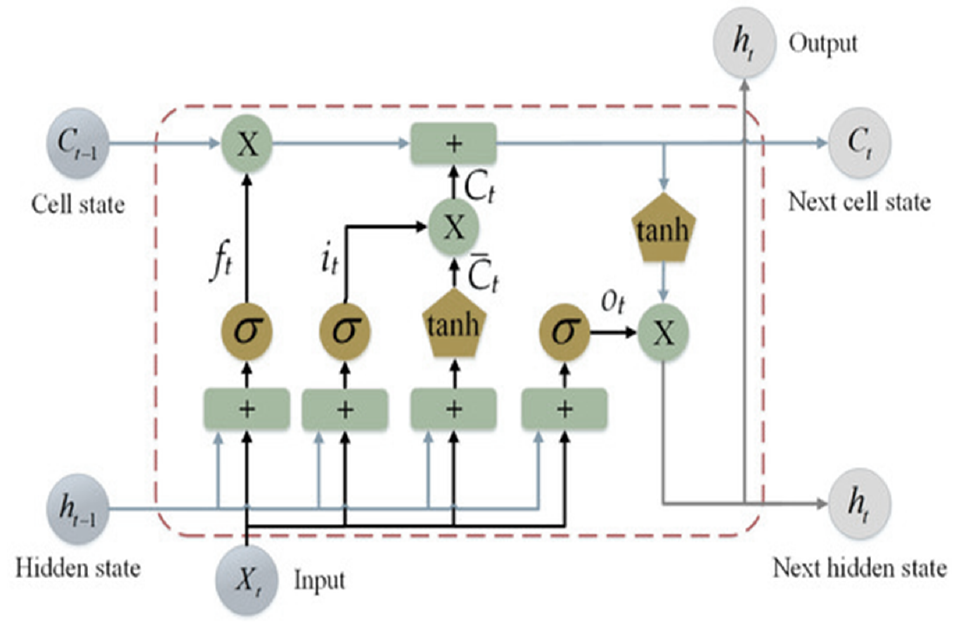
Figure 2. Structure of LSTM Model .